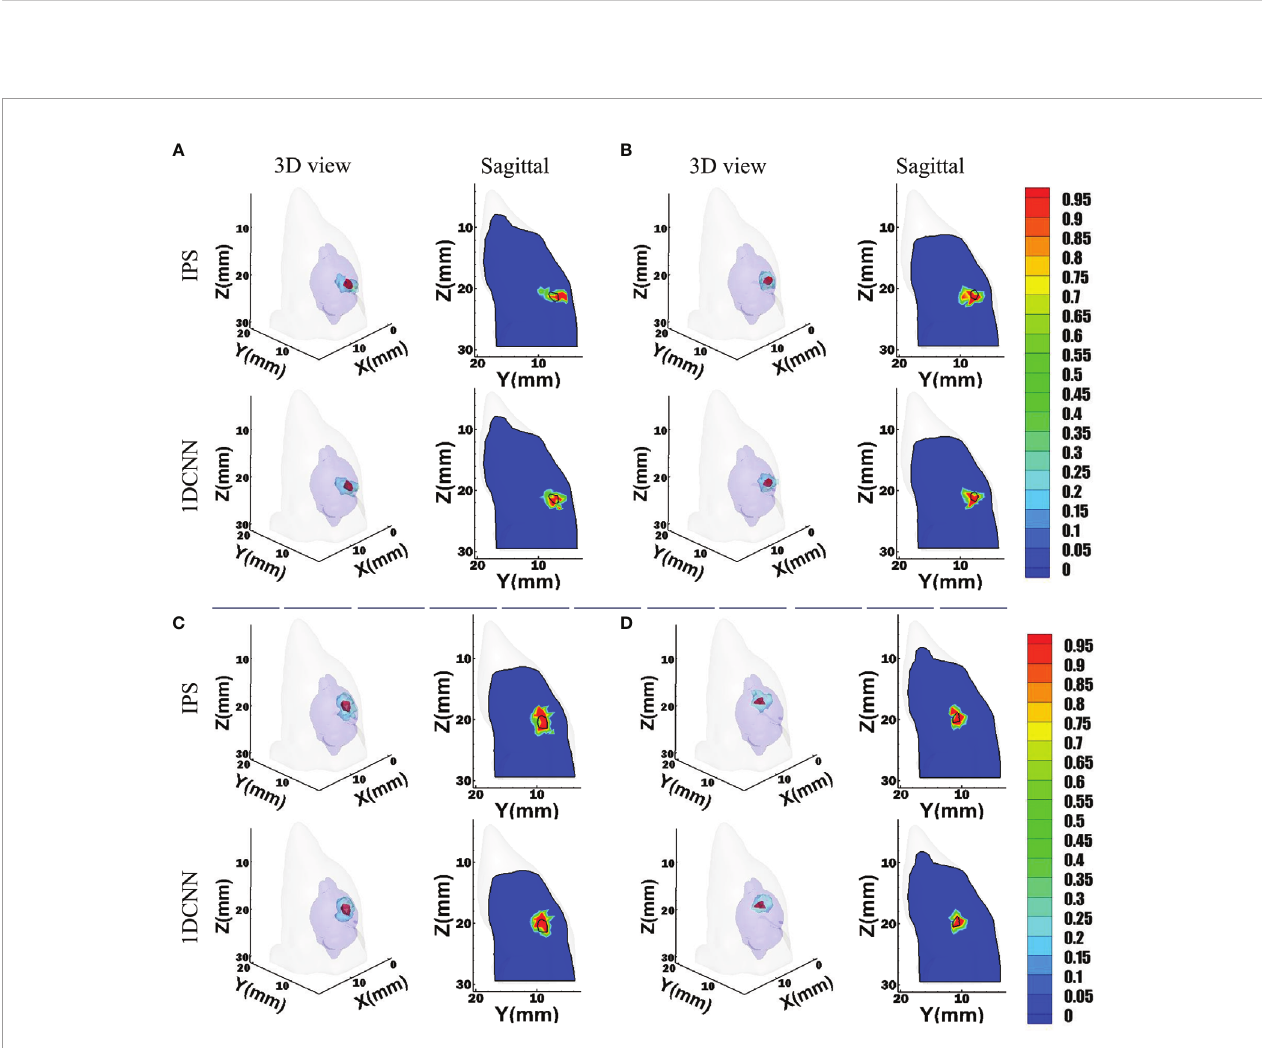
FIGURE 3 | Reconstruction results of 1DCNN and IPS in the single-source case, including the 3D views and the corresponding sagittal views at the true source center: (A) Depth = 2.9 mm; (B) Depth = 3.5 mm; (C) Depth = 4.3 mm; (D) Depth = 6.7 mm.